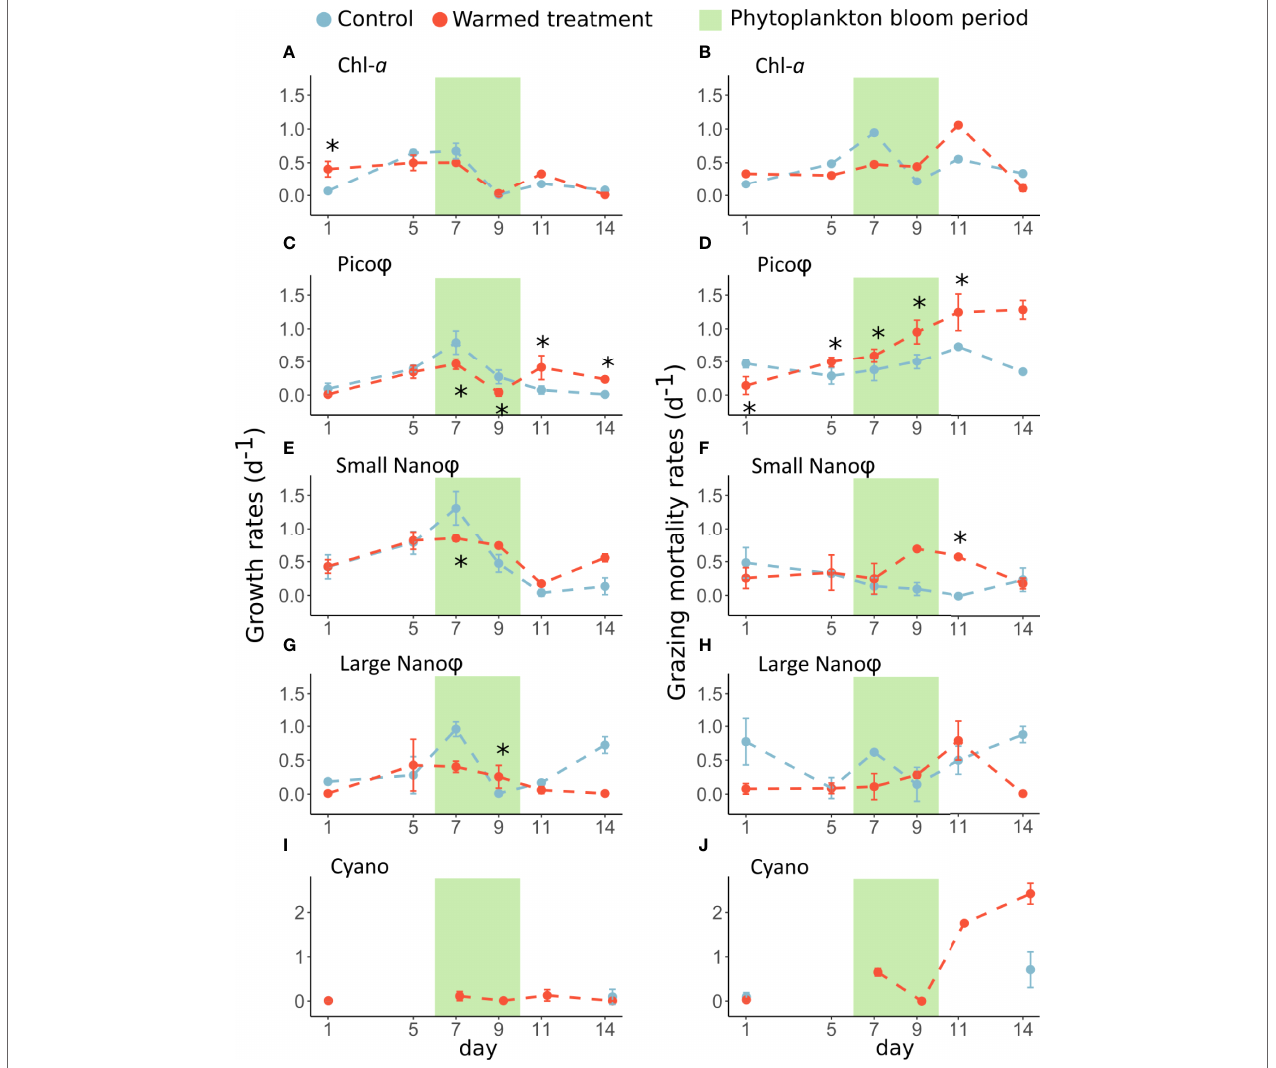
FIGURE 4 | Dynamics of the mean (± standard deviations) of growth and grazing mortality rates in the left and right panels, respectively, based on Chl- a concentration (A, B) or based on cytometry count for eukaryotic picophytoplankton (C, D) , small nanophytoplankton (E, F) , large nanophytoplankton (G, H) and cyanobacteria (I, J) in the control (blue) and warmed (red) treatments. The stars (*) represent a significant difference ( p < 0.05) in the mean growth or grazing mortality rates between the control and warmed treatments. The green rectangle highlights the period of phytoplankton